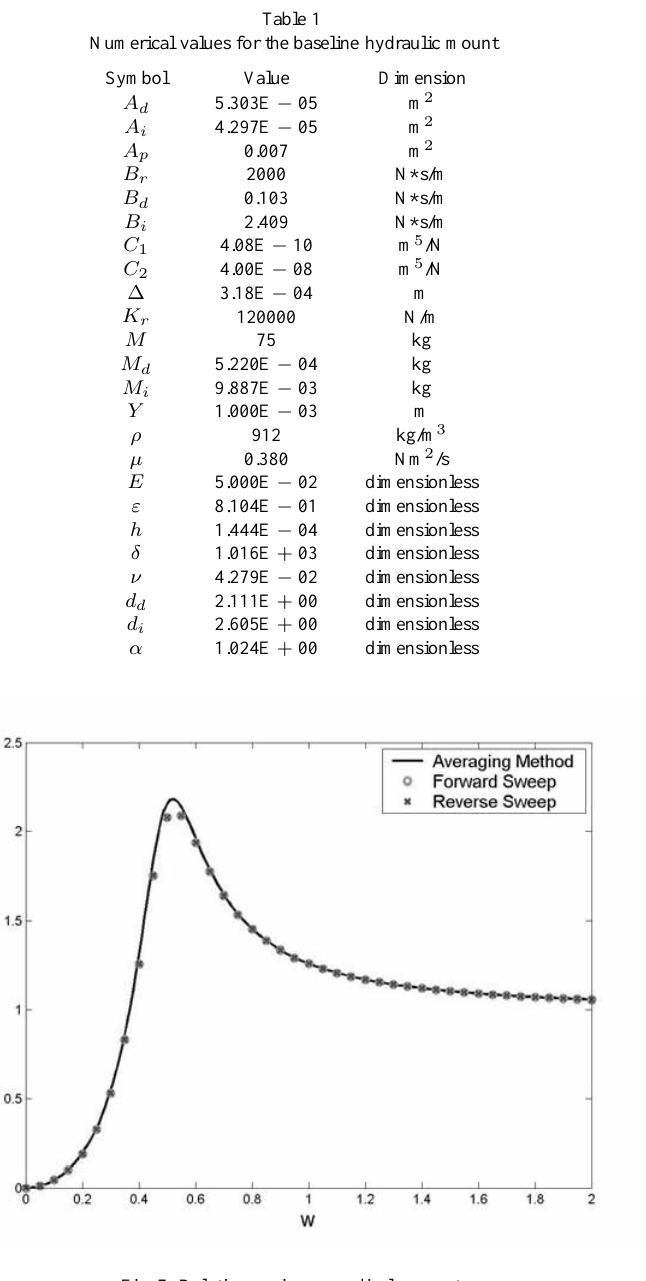
Fig. 7. Relative engine mass